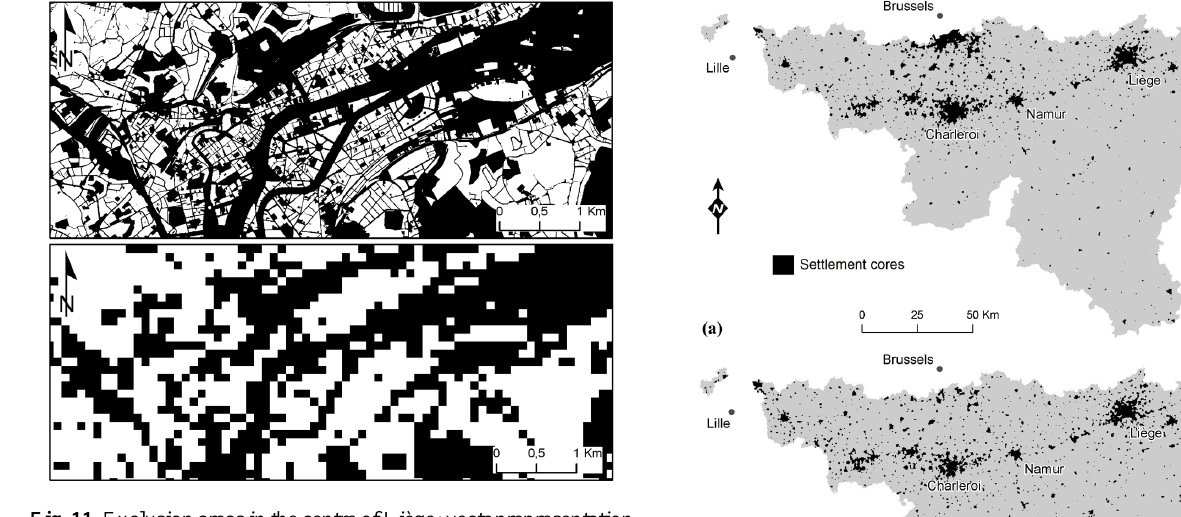
Fig. 11. Exclusion areas in the centre of Liège: vector representation of raw data (top) and raster representation used in the analysis (bottom).